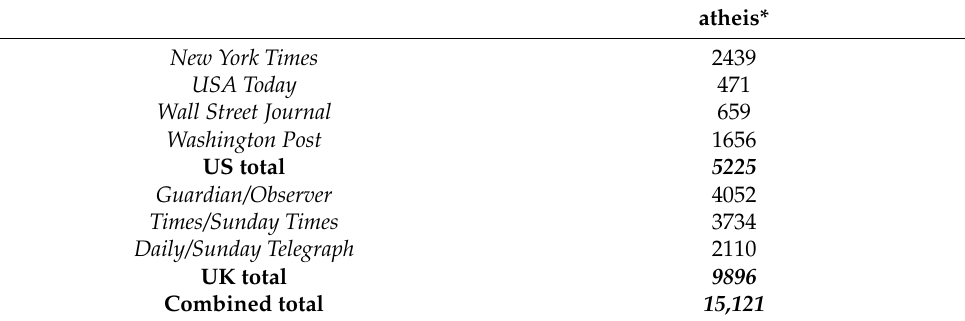
Table 1. Atheism corpus: number of articles by